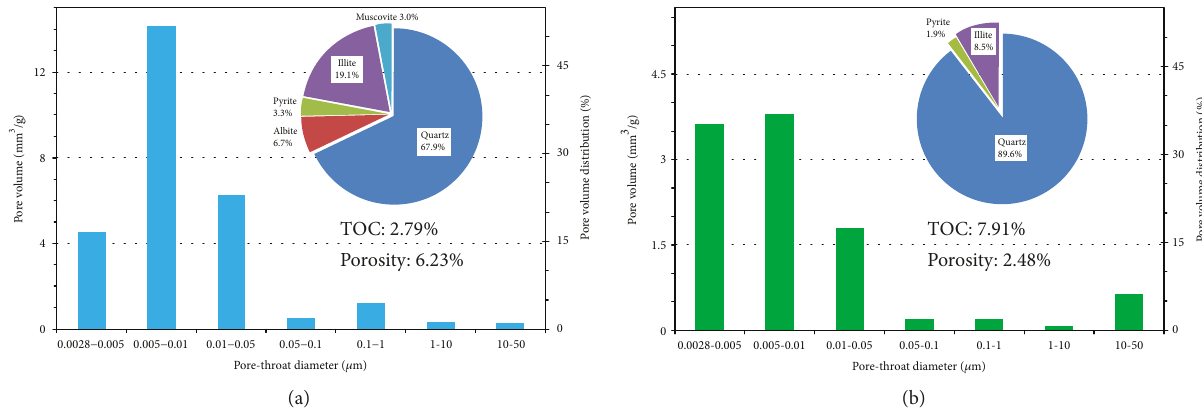
Figure 4: Pore-throat size distribution versus mineralogy for (a) B-13010 and (b) B-13047; QFM: quartz, feldspars, and mica.